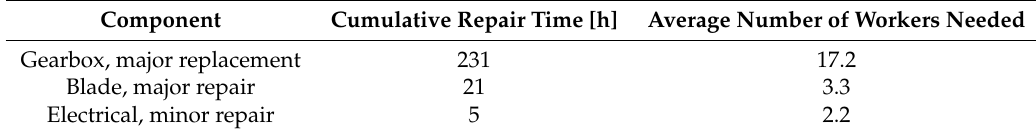
Table 4. Turbine components that are investigated in the case study and their repair parameters.